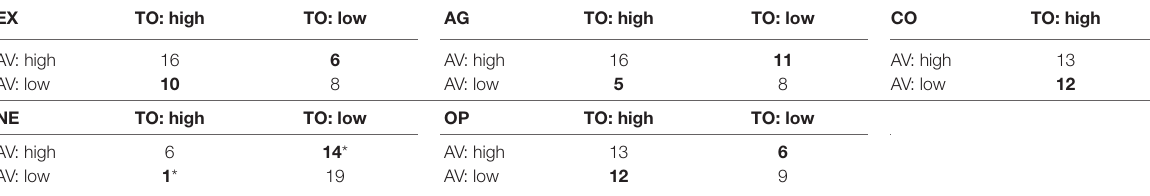
TaBle 3 | contingency tables for each trait (at a significance level of * p <